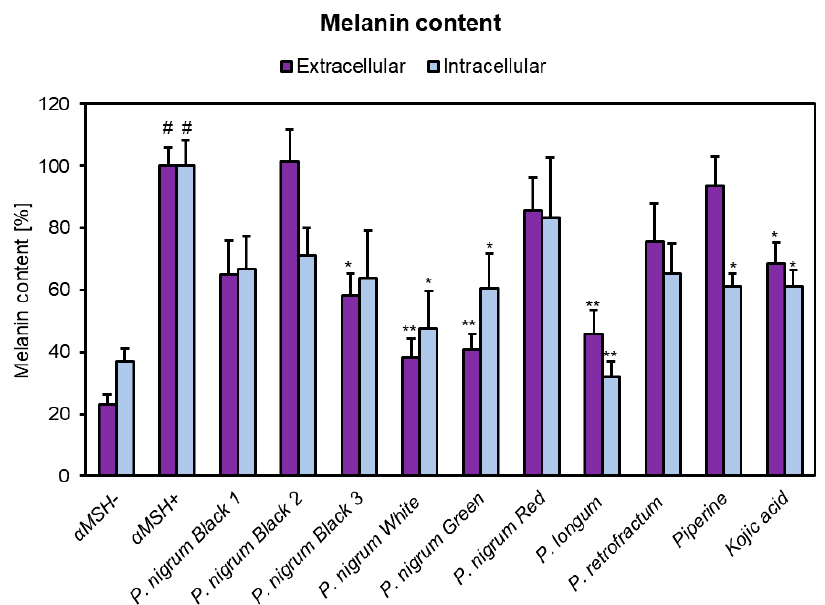
Figure 4. Melanin inhibitory activity in α MSH-stimulated B16F10 cells of the methanolic fruit extracts obtained from different spices of genus Piper , piperine and kojic acid. B16F10 cells were seeded in 6-well plates (0.5 × 10 5 /well) and incubated for 72 h with Piper extracts (10 µ g/mL), piperine (10 μ g/mL) or kojic acid (10 μ g/mL); melanin production was stimulated with α MSH (10 nM). Data are presented as the percentage of intracellular and extracellular melanin content in comparison to α MSH stimulated control ( α MSH+) cells, set at 100%. Each bar represents the mean ± S.E.M. of at least three independent experiments performed in triplicates; # p <0.001 vs. non-stimulated ( α MSH-) cells; * p < 0.05; ** p < 0.01; vs. α MSH+ cells.